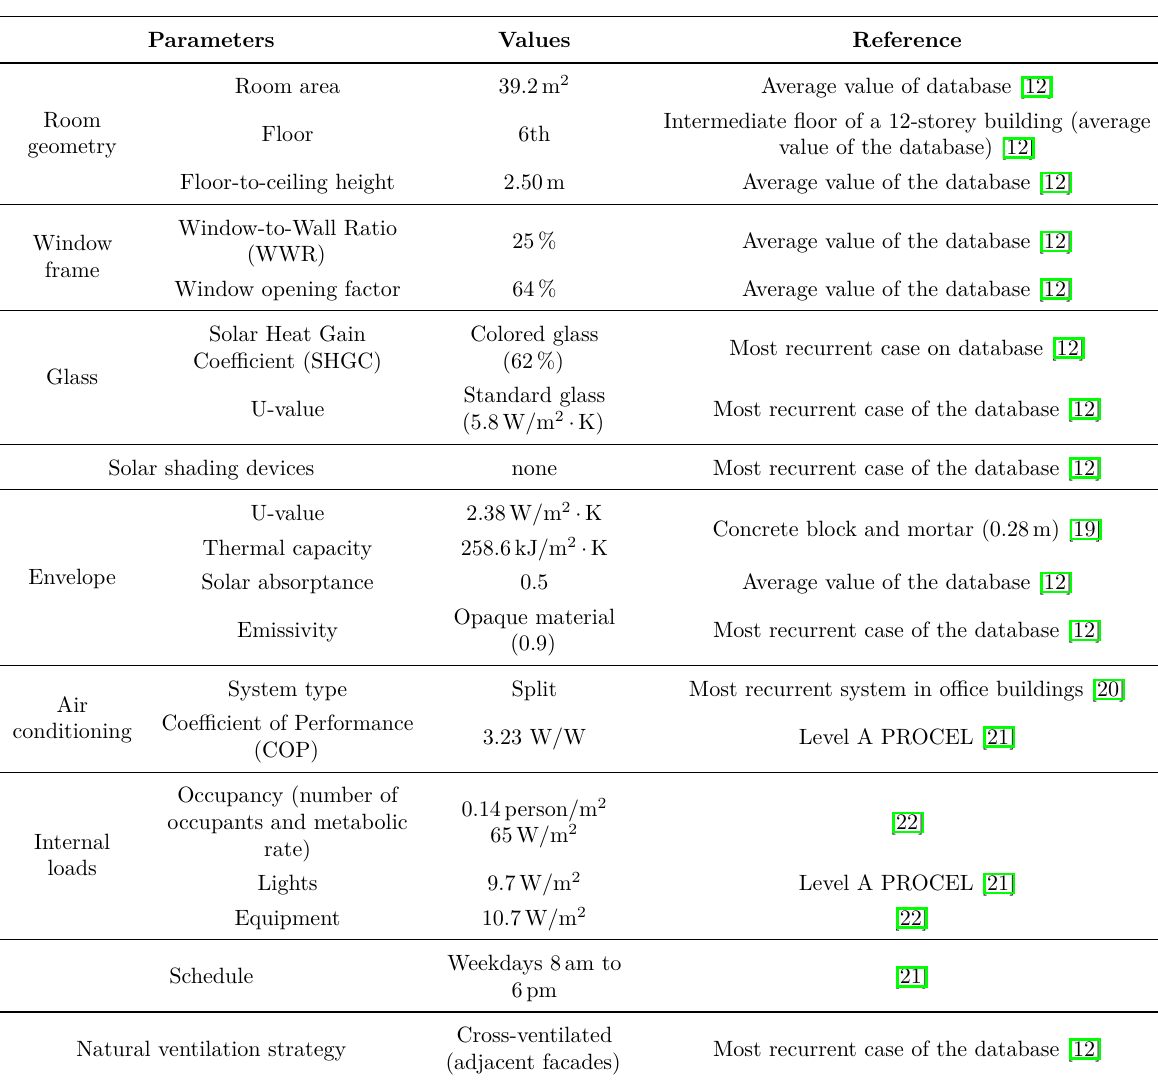
Table 1. Reference model’s input parameters.